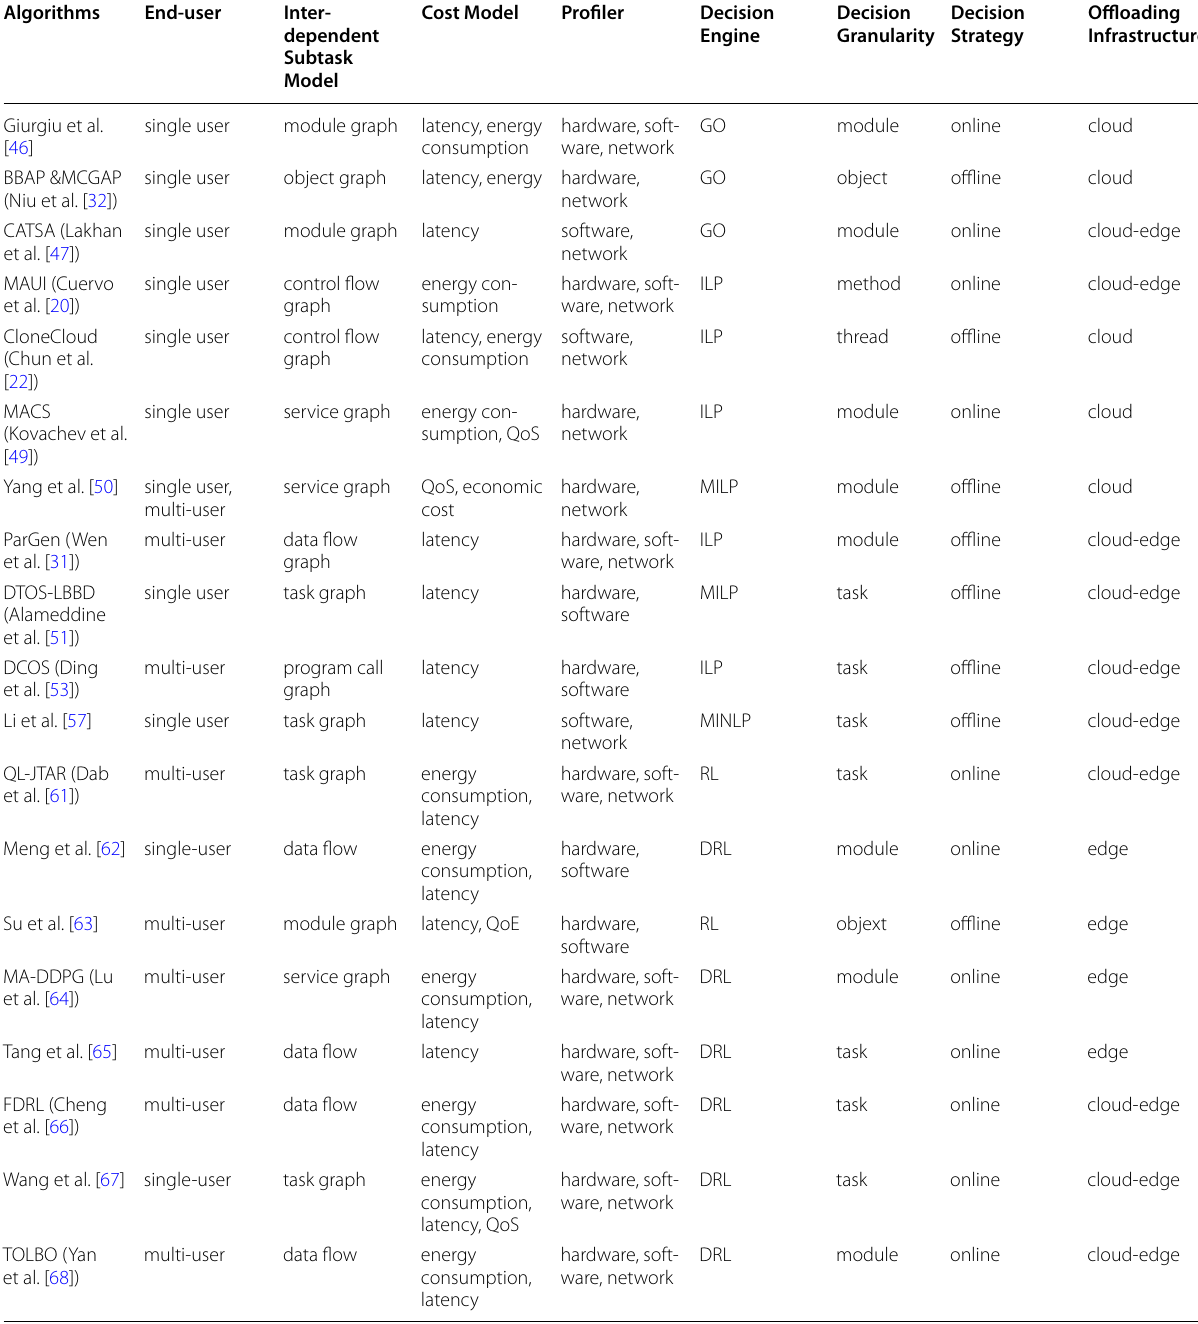
Table 2 Task partitioning and offloading decision optimization approaches based on the proposed taxonomy metrics